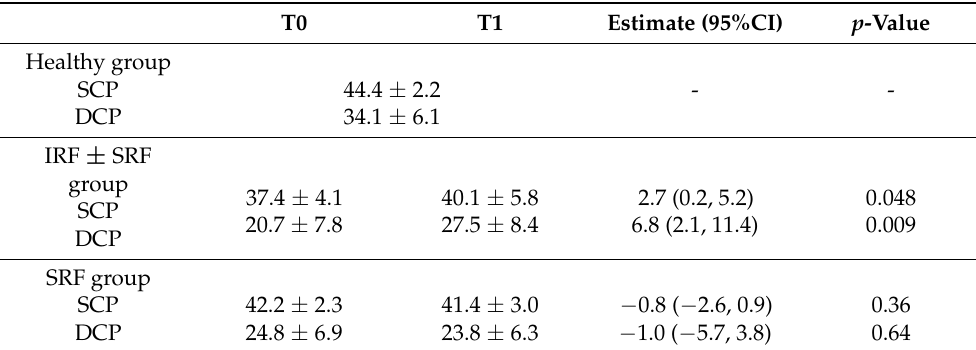
Table 6. Effect of time on mean perfusion density (MPD) according to the patient group and plexus analyzed. The analyses were performed using a multivariable linear mixed effects model including age, fibrosis and atrophy as covariates. The estimate gives the increase or decrease in the variable between T0 and T1 independently of age, fibrosis and